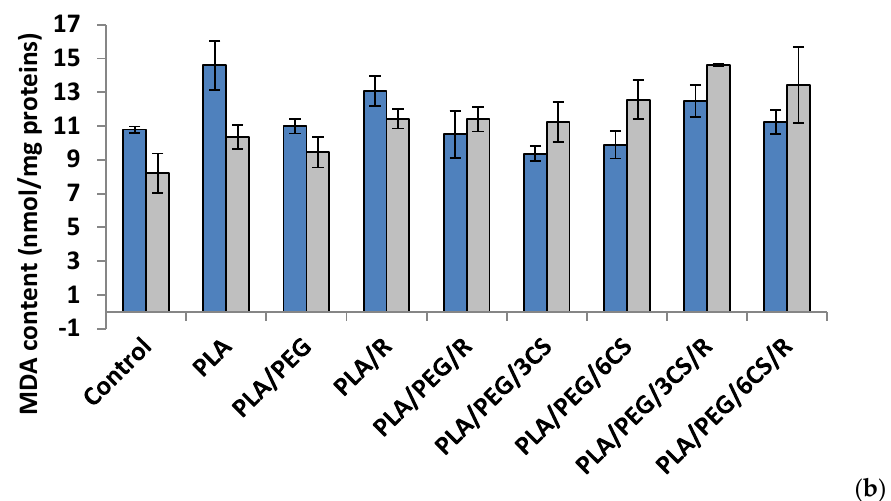
Figure 6. Malondialdehyde (MDA) content in P. chrysosporium (dark blue columns) and C. globosum (grey columns) after 7 days ( a ) and 14 days ( b ) of incubation in the presence of PLA-based samples.